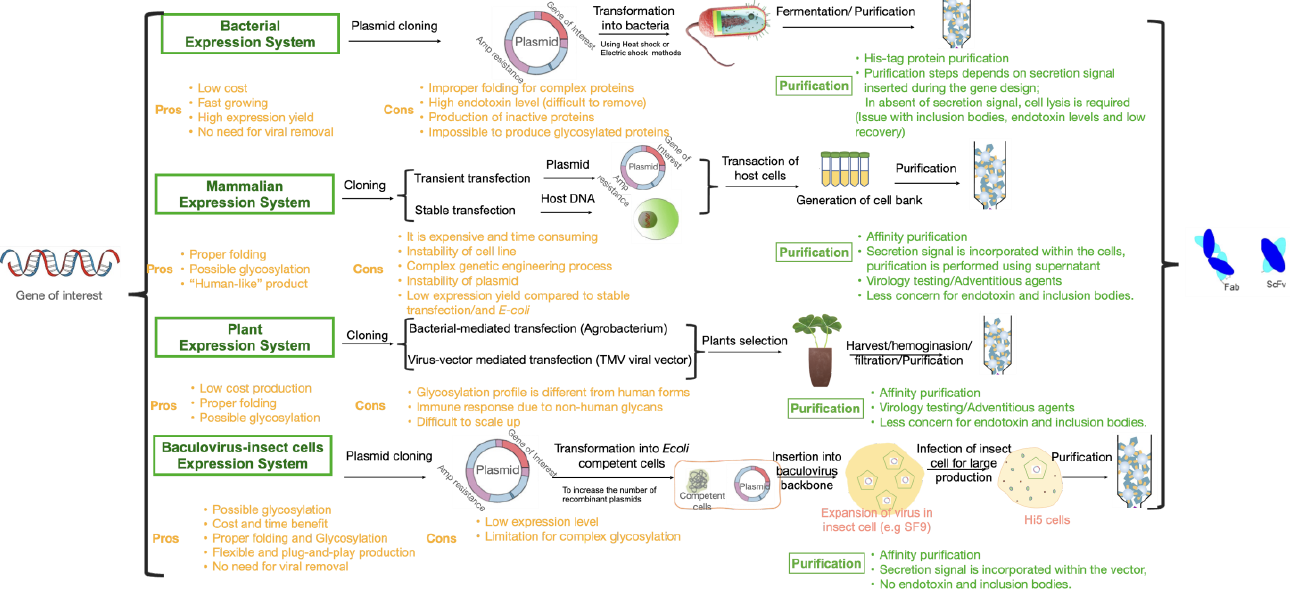
Figure 2. Challenges and opportunities for different expression systems to bioengineer Fabs and scFvs.